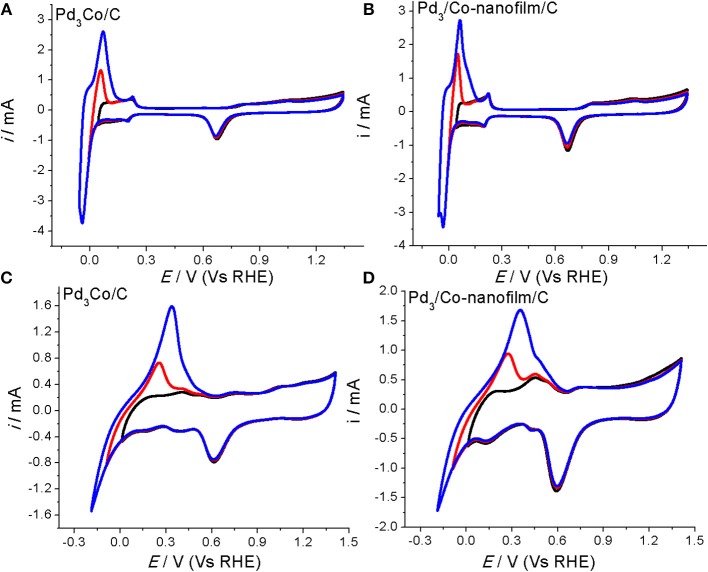
CVs of the prepared Pd3Co/C and Pd3/Co-nanofilms/C catalysts at room temperature 27°C in the different potential regions (A,B) in Ar-saturated 0.5 M H2SO4 and (C,D) in Ar-saturated 0.1 M NaOH. Scanning rates: 50 mV/s.